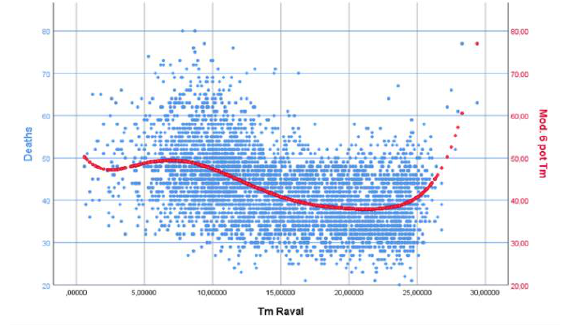
Figure 3. Deaths vs. Minimum Temperatures (2007-2018)